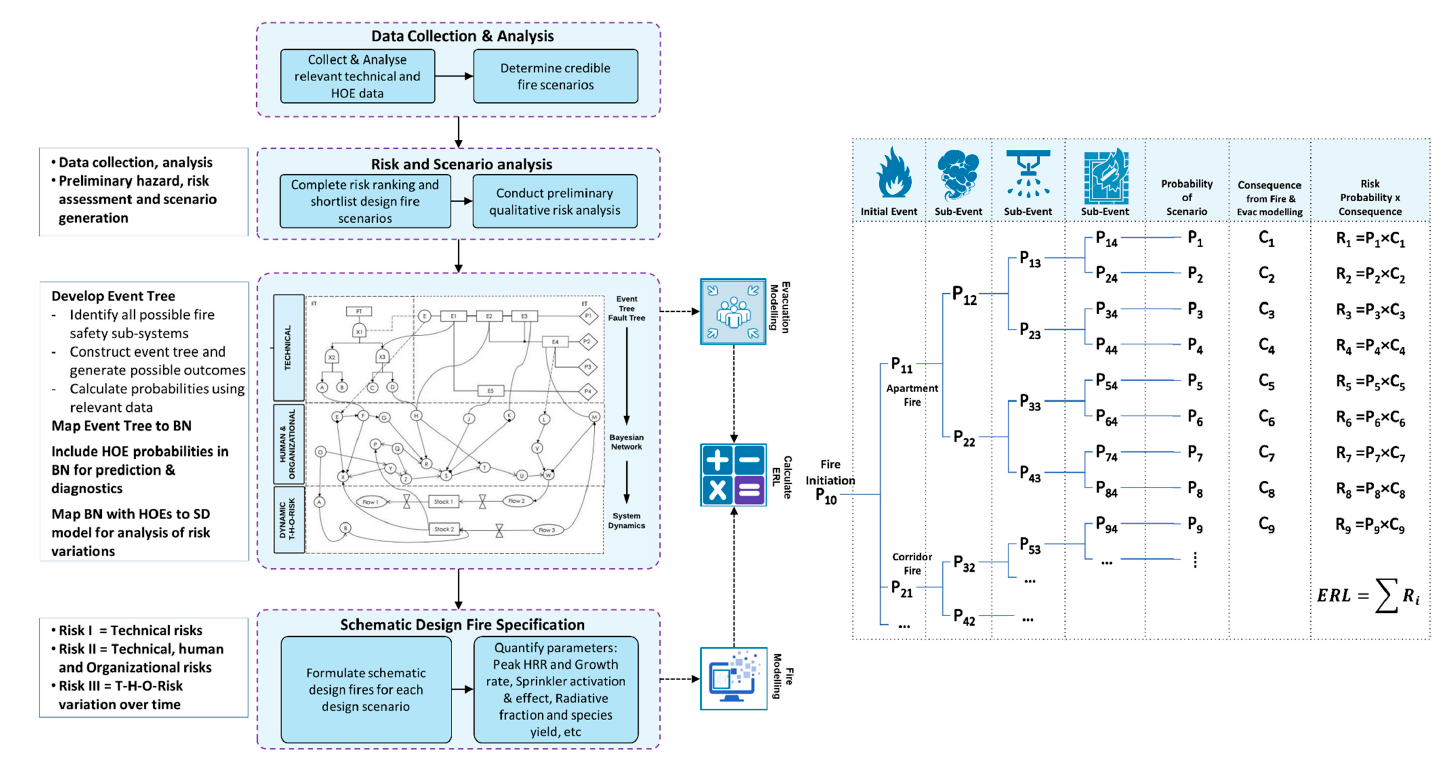
Figure 1. Technical-Human-Organizational-Risk (T-H-O-Risk) methodology. Note: ERL: Expected risk to life; BN: Bayesian Network; HOE: Human and Organization Error; SD: System dynamics; R: Risk; P: Probability; C: Consequences